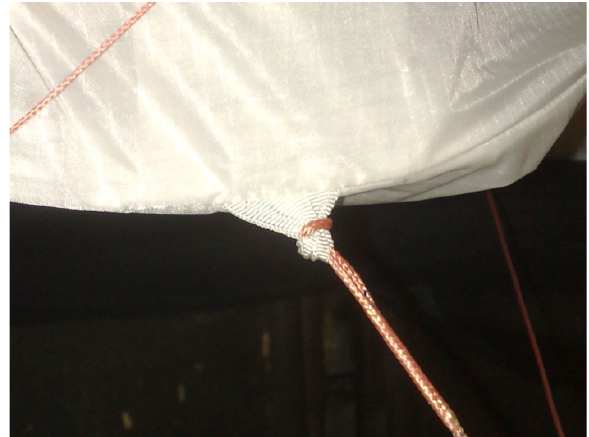
Fig. 5: Vertex to be measured 3.4 Taking photographs vs. safety aspects